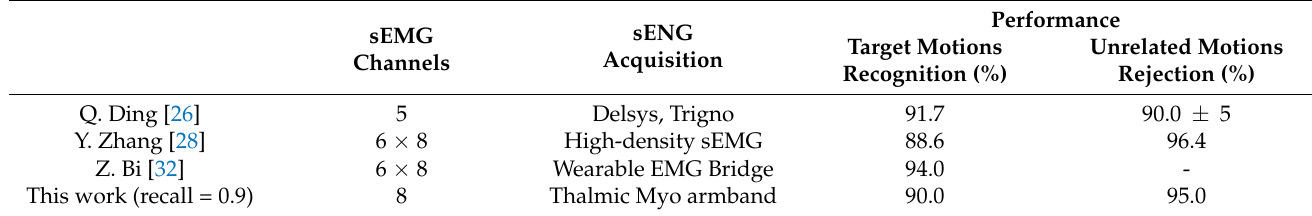
Table 2. The comparison with the related studies .